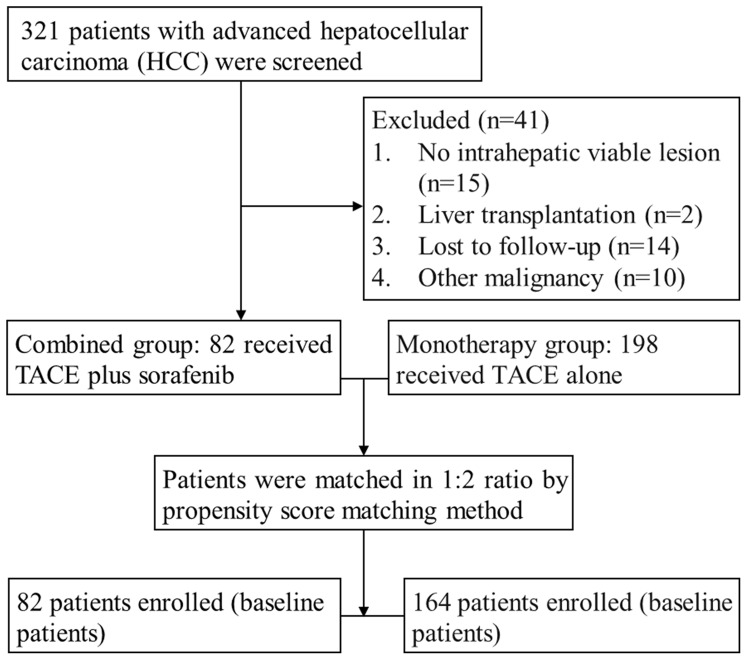
Patient selection.